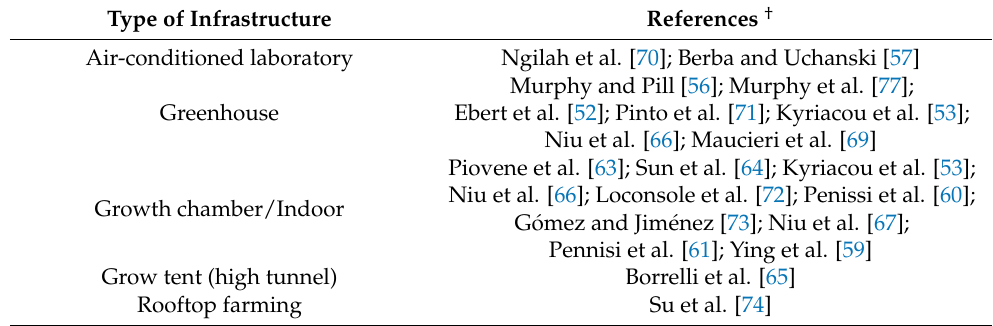
Table 2. Facilities investigated for producing leafy vegetables indoor †